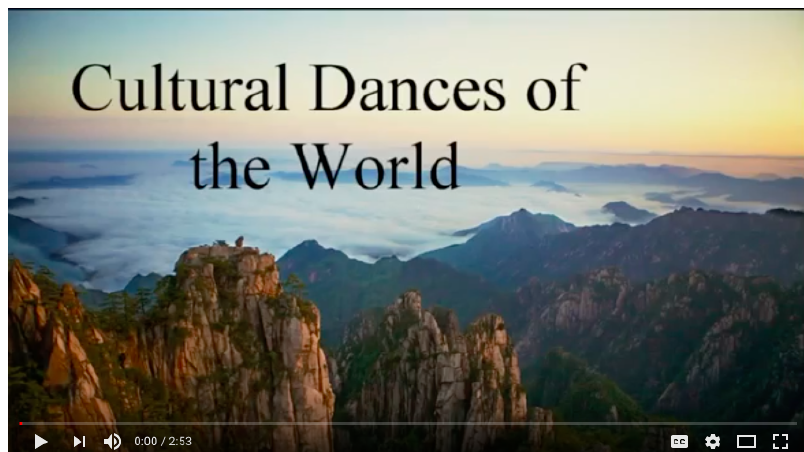
Figure 3. Screen shot of student mentor video on critically inquiring into identity and culture through